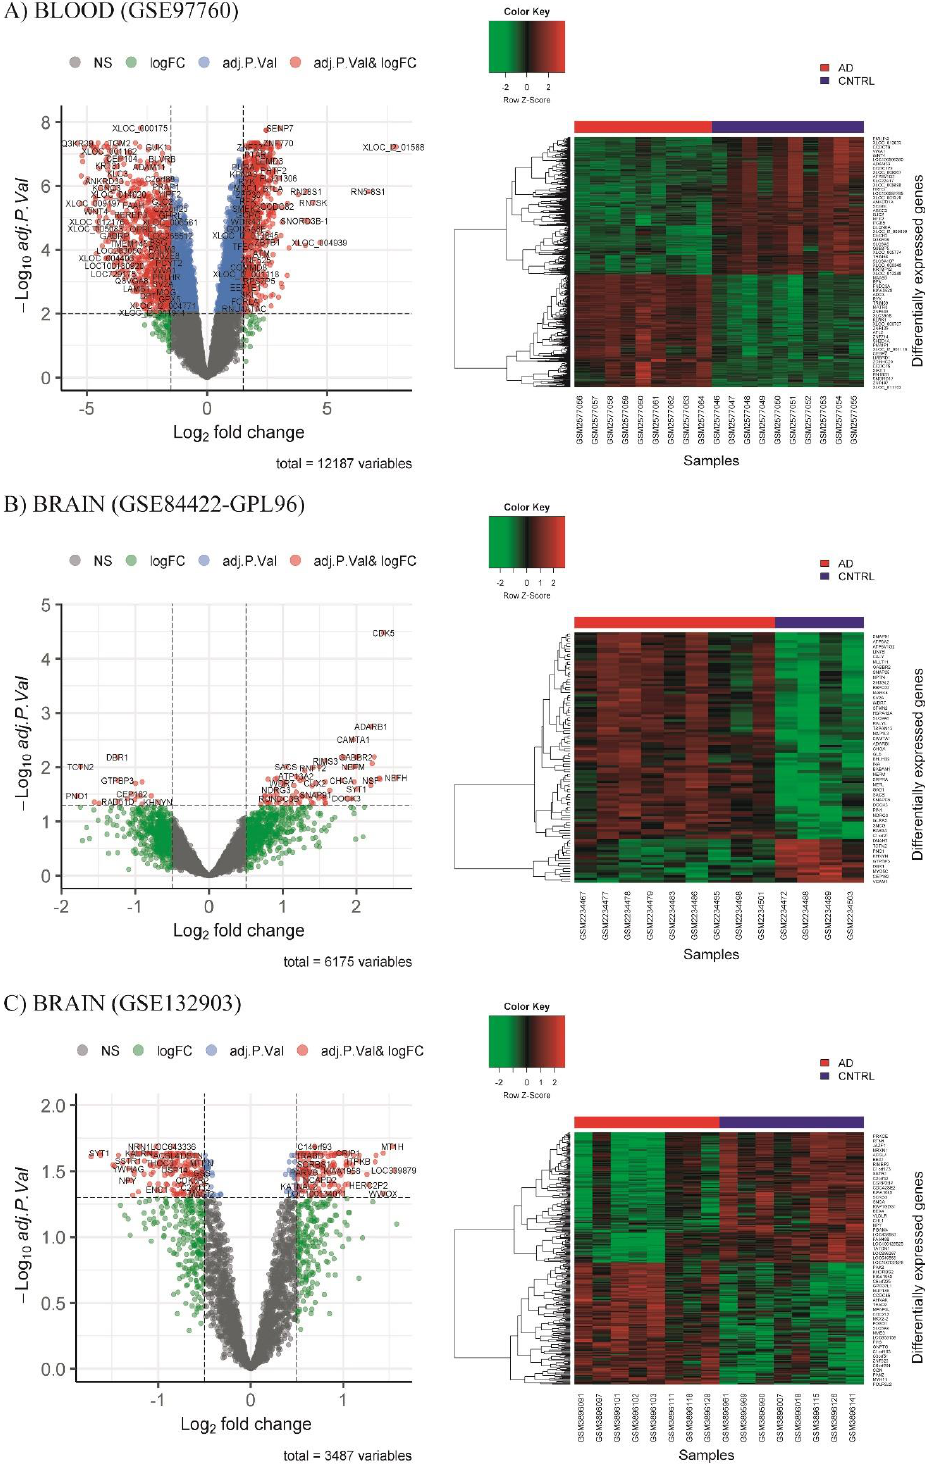
Figure 4. Volcano plot of up- and downregulated differentially expressed genes (DEGs) when comparing Alzheimer’s disease (AD) samples with healthy control samples (CNTRL), and heat map with logarithmic scale expression of DEGs in AD and CNTRL samples. CNTRL in blue, AD in red, purple line = median value, principal component 1, Dim1; principal component 2, Dim2; not significant, NS; genes with − 0.5 > fold change < 0.5 (green dots); genes with − 0.5 > fold change < 0.5 and adjusted p value (adj.P.val) < 0.05 (red dots). Data of ( A ) blood GSE97760, ( B ) brain GSE84422-GPL96, and ( C ) brain